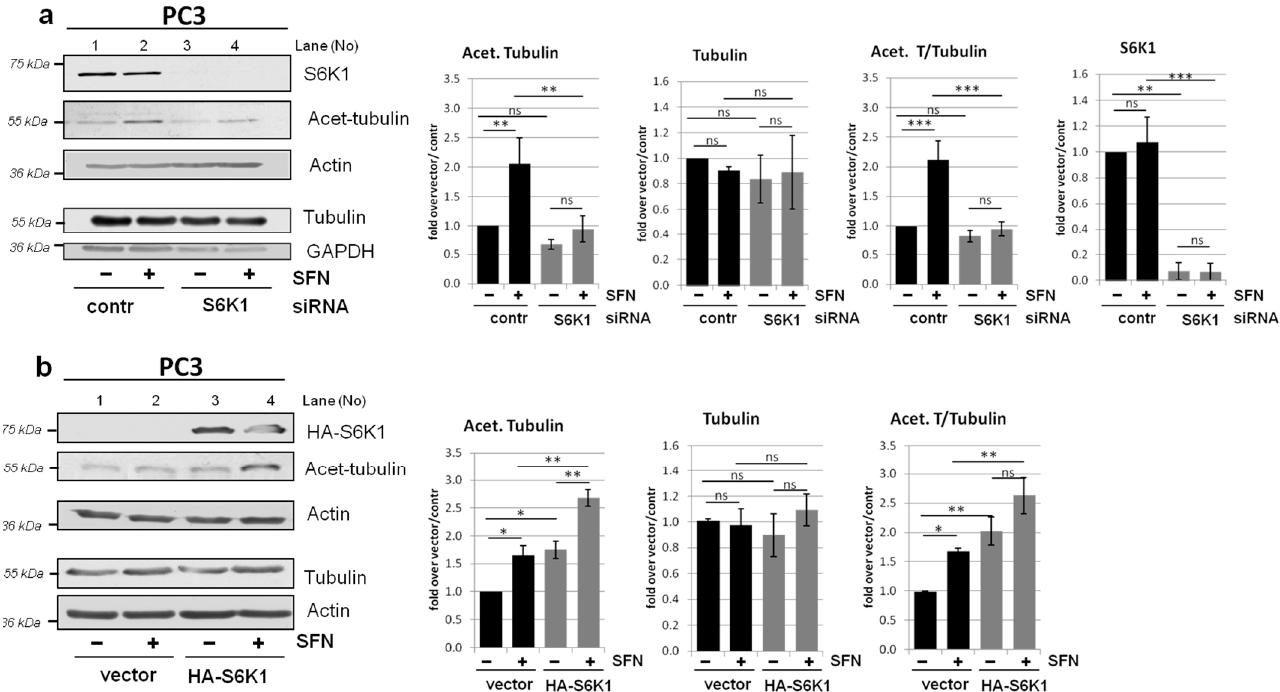
Figure 8. Modulation of tubulin acetylation by S6K1 is conserved in different cellular models. Prostate cancer cells (PC3) were transfected with ( a ) a control or S6K1-targeting siRNA, or ( b ) a control or HA-S6K1–encoding vector ( b ). The cells were treated with DMSO (control) or SFN for 3 h. Acetylated tubulin, S6K1, and HA-S6K1 protein levels were evaluated by western blotting. The blots were re-probed with anti- β -actin antibodies to ensure equal protein loading. Graphs next to immunoblots show densitometric data, corrected for loading control and presented as fold-changes from the reference, untreated control cells ( lane 1 ). The experiment was performed in three independent replicates. The data are shown as the mean ± SEM. The statistical significance of differences was determined by one-way ANOVA followed by Bonferroni’s multiple comparison test: * p < 0.05, ** p < 0.01, *** p < 0.001; ns, not significant.